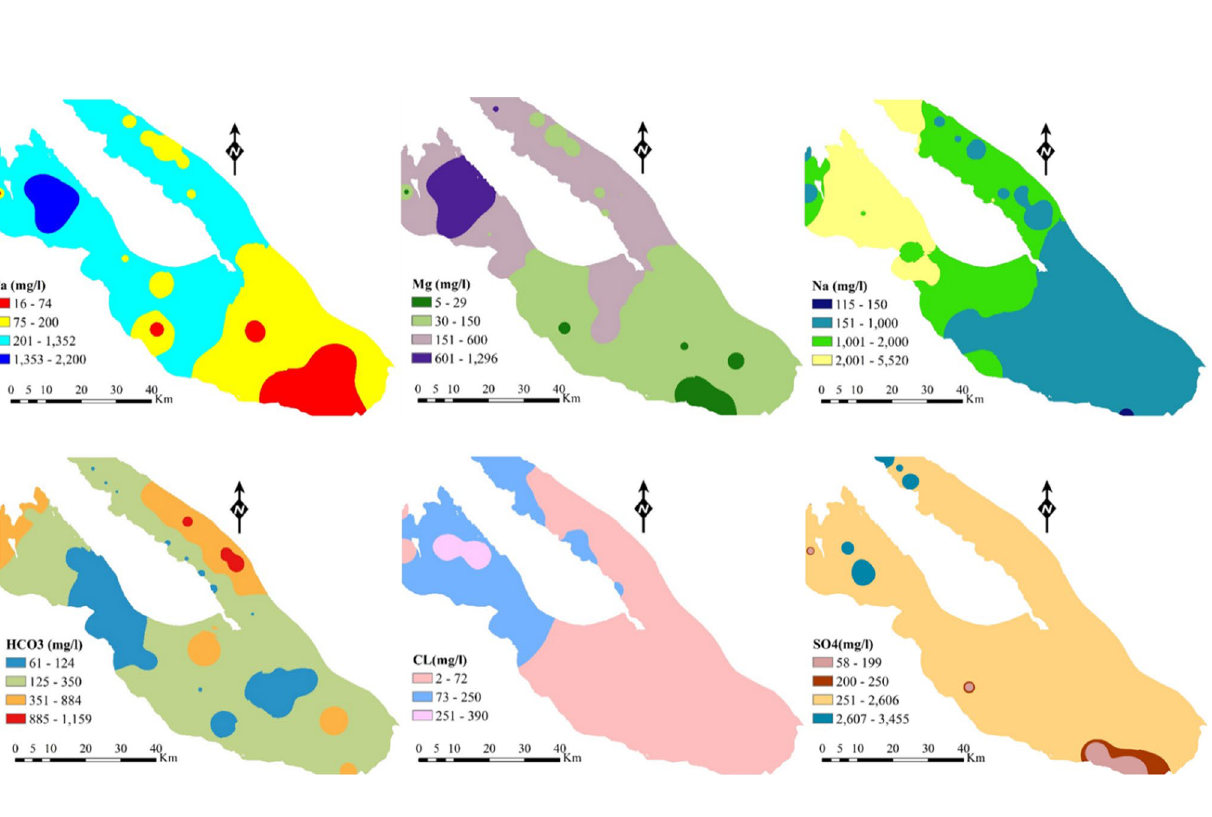
Fig. 7 Spatial distribution of major cations and anions in the study